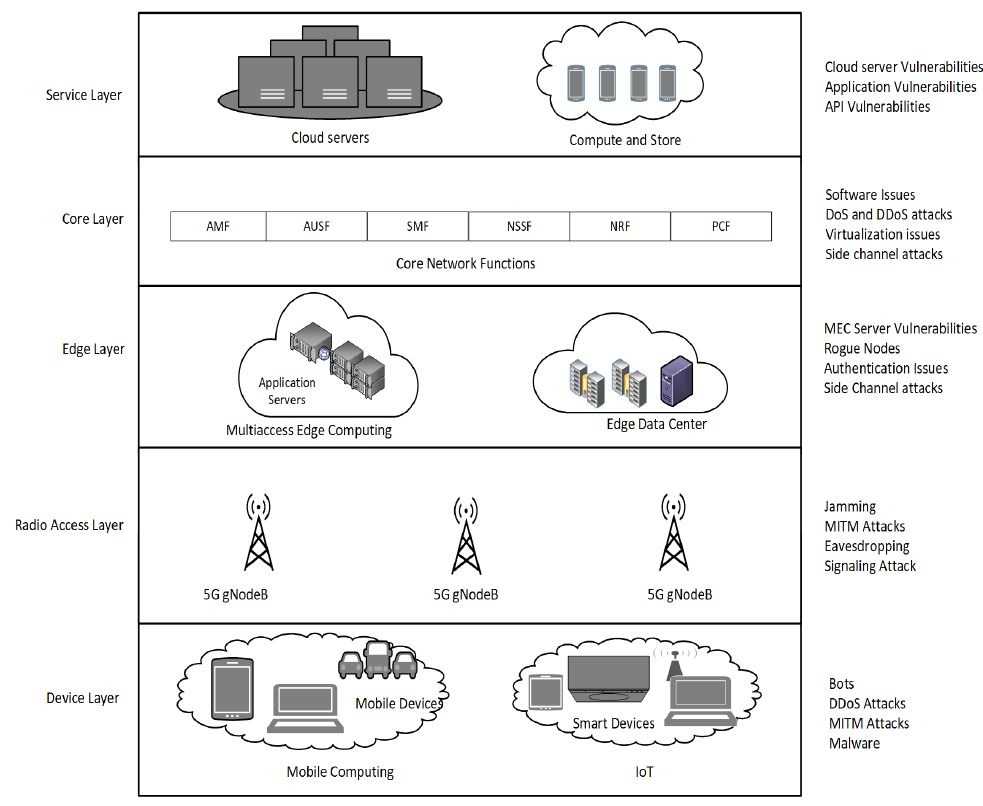
Figure 1. 5G layered